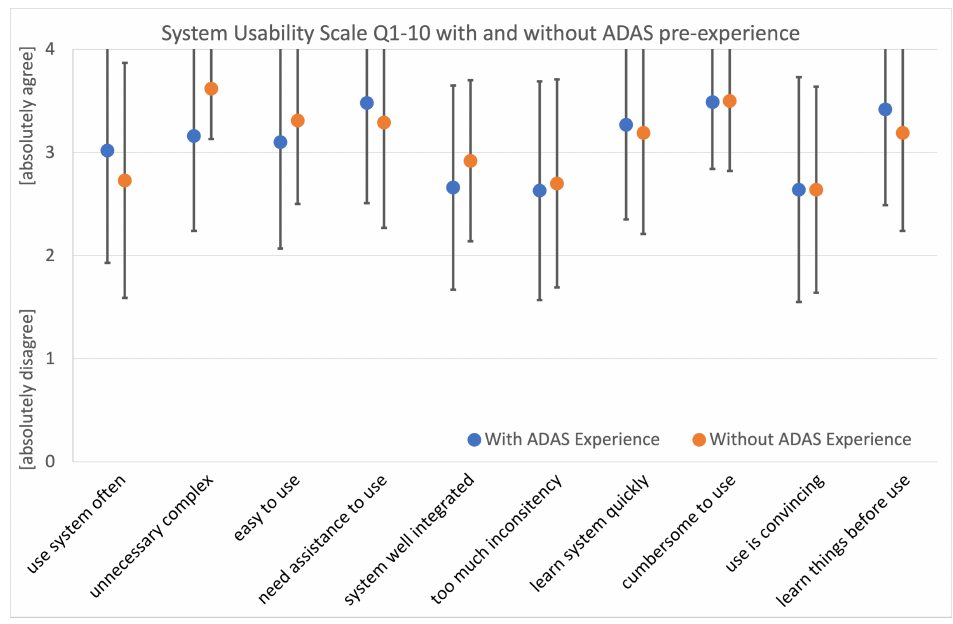
Figure 9. SUS scores for the single questions for the groups with and without ADAS pre-experience, inverted for negative